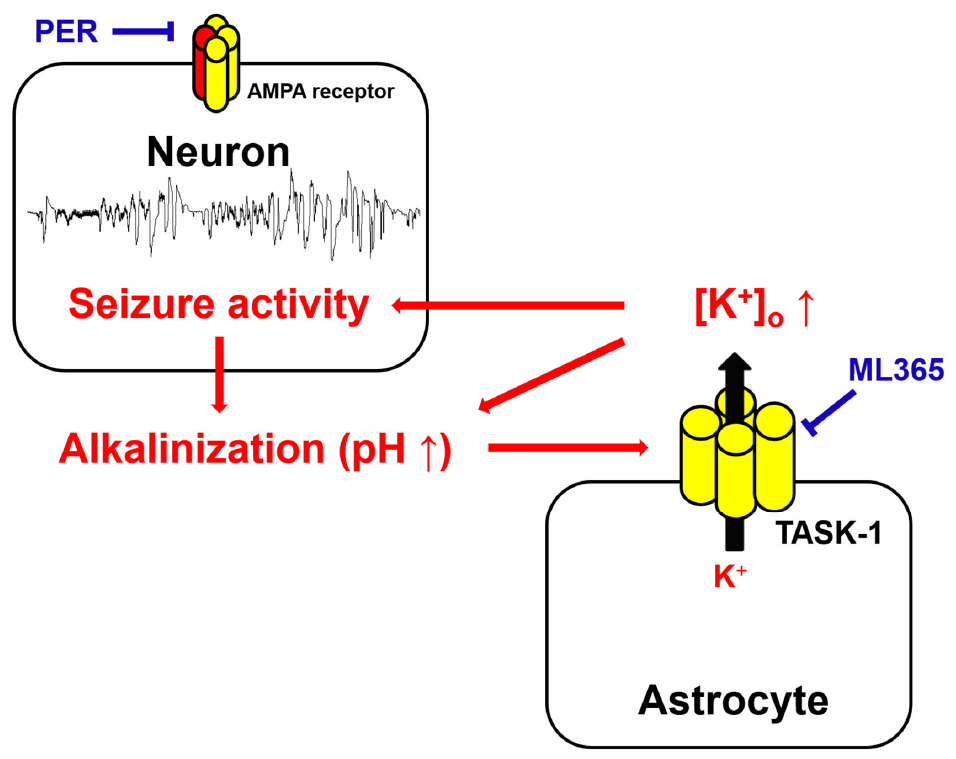
Figure 9. Schematic depiction representing the role of AMPAR–TASK-1 interactions in seizure activity. AMPAR hyperactivation generates seizure activity leading to extracellular alkaline shifts. Under this condition, astroglial TASK-1 channels may be activated and subsequently increase K + efflux from astrocytes. In turn, TASK-1-channel-mediated extracellular K + elevation further augments seizure activity (Red arrows or letters indicate the underlying mechanisms of uncontrolled seizures in response to PER. Blue bars or letters indicate the inhibitor of AMPA receptor and TASK-1 channel to cease the spontaneous seizures).